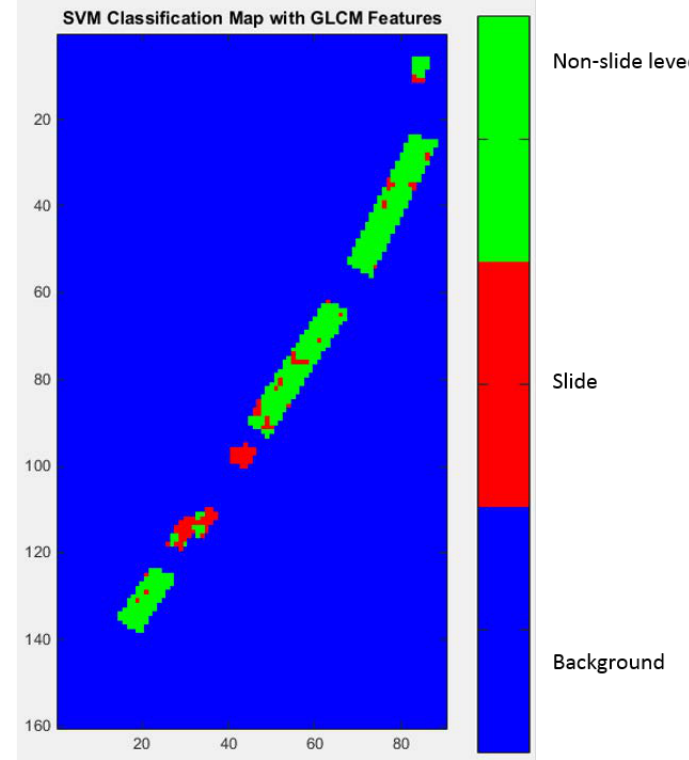
Figure 9. SVM Classification map for UAVSAR data set using GLCM features with σ = 1.7 and block size B = 9 (window is B × B